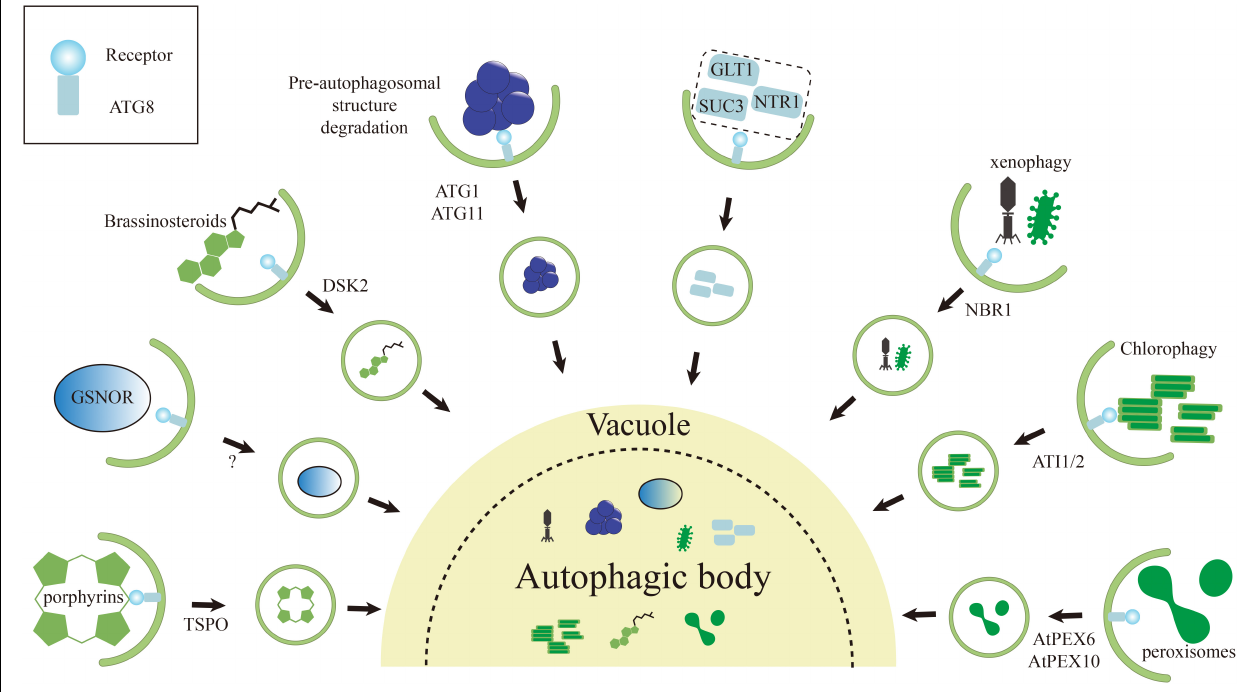
FIGURE 3 | Schematic representation of various selective autophagy pathways known in plants. The autophagic degradation routes for organelles, protein complexes, protein aggregates, and pathogens are shown, and unique features of each are highlighted. Numerous examples of intracellular pathogens being degraded by autophagy (called xenophagy), such as NBR1-mediated elimination of the cauliflower mosaic virus (CaMV) P4 protein. Interestingly, the turnip mosaic virus (TuMV) could induce unfolded protein response (UPR)-dependent NBR1-ATG8 autophagy to enhance virus propagation to protect itself. Degradation of chloroplasts via chlorophagy may occur through the formation of ATI1/2-decorated bodies containing plastid membrane proteins from either the outer envelope or thylakoids during the carbon starvation or salt stress. Both peroxisome proteins PEX6 and PEX10 can interact with ATG8 via their own AIMs, suggesting that these proteins may trigger pexophagy to maintain the cell validity. Both ATG1 and ATG11 contain an AIM that likely connect ATG1 kinase complex to the pre-autophagosomal structure. The interaction may not only help the pre-autophagosomal structure assembly, but also promote its autophagic turnover. Degradation of tryptophan-rich sensory protein (TSPO) by selective autophagy has been supposed as an iron metabolic mechanism to effectively clear porphyrins in cell and to control the water uptake by selective removal of plasma membrane aquaporins during osmotic stress. The brassinosteroid (BR) signaling transcription factor BES1 is degraded by selective autophagy upon ubiquitylation and delivery to the phagophore by DSK2, with binding to the ATG8 regulated by BIN2-mediated phosphorylation around its AIMs. NO-mediated S -nitrosylation of GSNOR because local conformational changes that render its AIM accessible for ATG8, thereby inducing selective autophagy of GSNOR to regulate hypoxia responses. Some rest ATG8-interacting proteins, including GLT1, NTR1/PTR2, and SUC3 in Arabidopsis